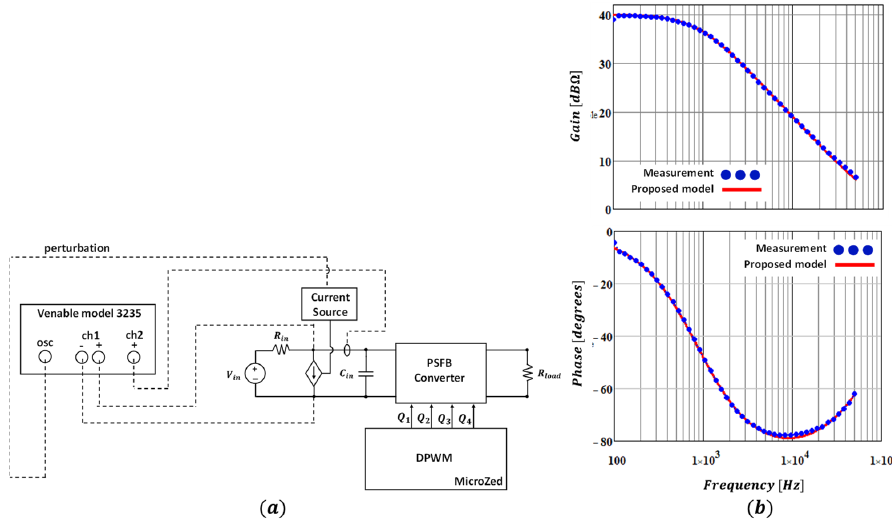
Figure 21. ( a ) Measurement block diagram. ( b ) Frequency response of the open-loop input impedance, 8.5 W.